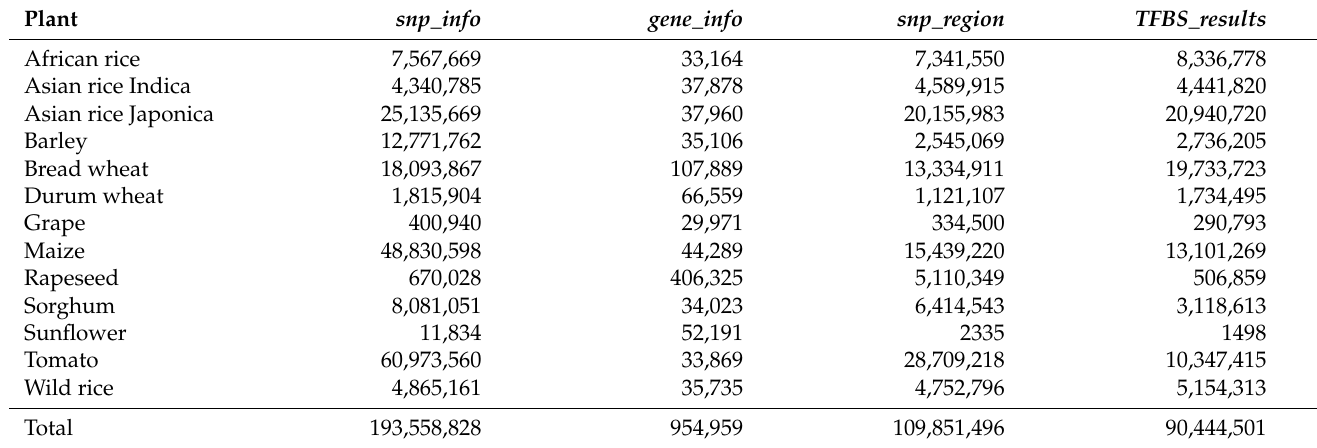
Table 2. The number of records stored in the database tables snp_info , gene_info , snp_region , and TFBS_results separated by